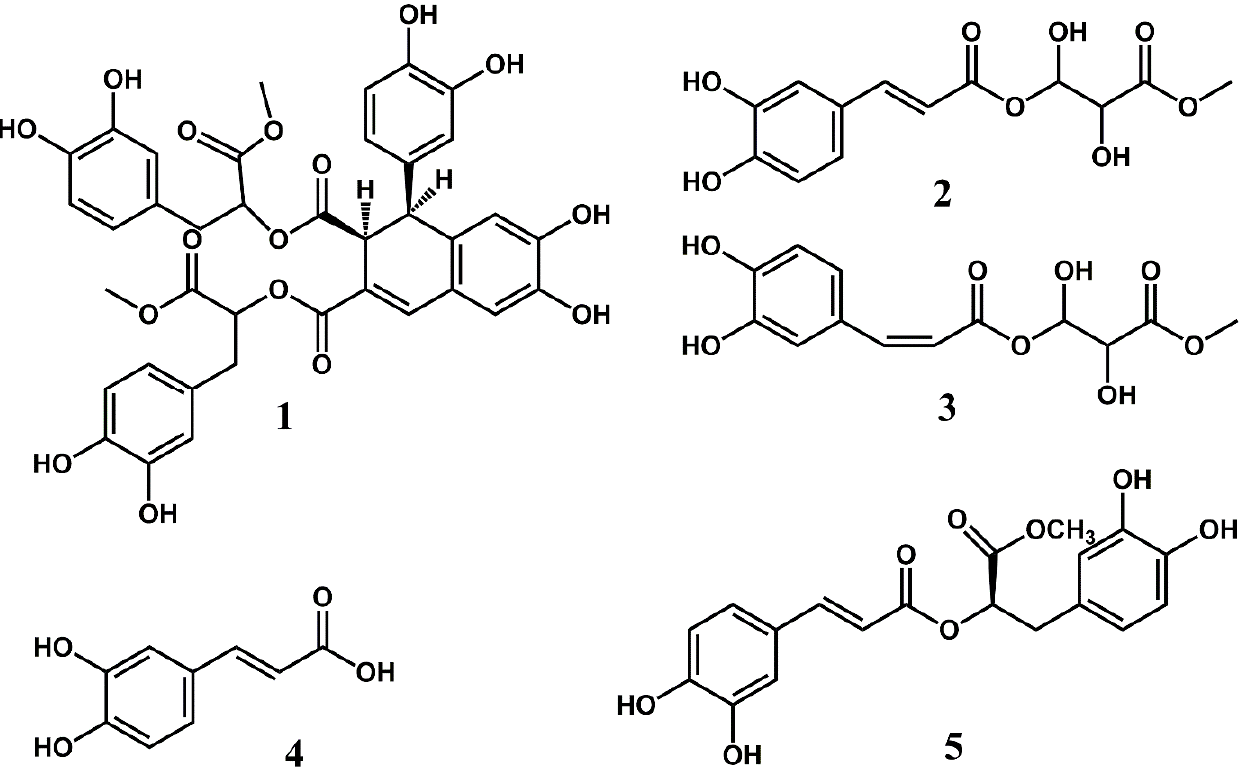
Figure 2. The molecular structures of compounds 1 – 5 characterized from leaves of Echium amoenum . Table 1. 1 H and 13 C NMR chemical shift values (ppm) and coupling constants (Hz) of compounds